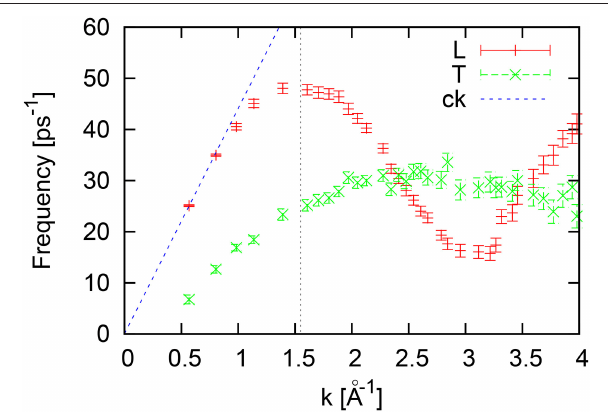
FIGURE 8 | Dispersion of longitudinal (L) and transverse (T) collective excitations for liquid Ni at 1735 K estimated from peak positions of the L/T current spectral functions. The vertical dashed line at k = 1.55Å − 1 corresponds to the boundary of the first pseudo-Brillouin zone.